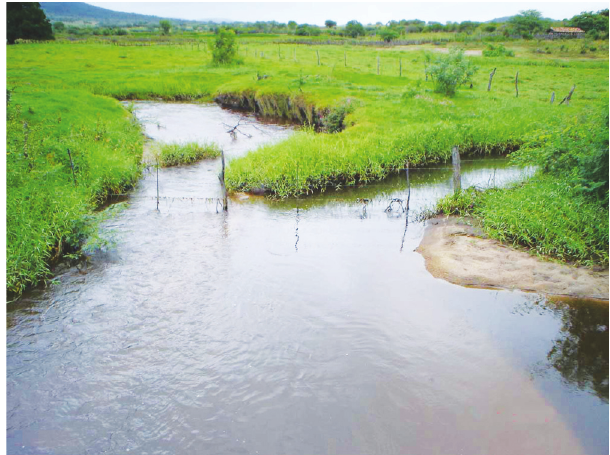
Fig. 9. Type locality of Trichomycterus payaya , Brazil, Bahia, Miguel Calmon, riacho Olhos d’água, rio Itapicuru